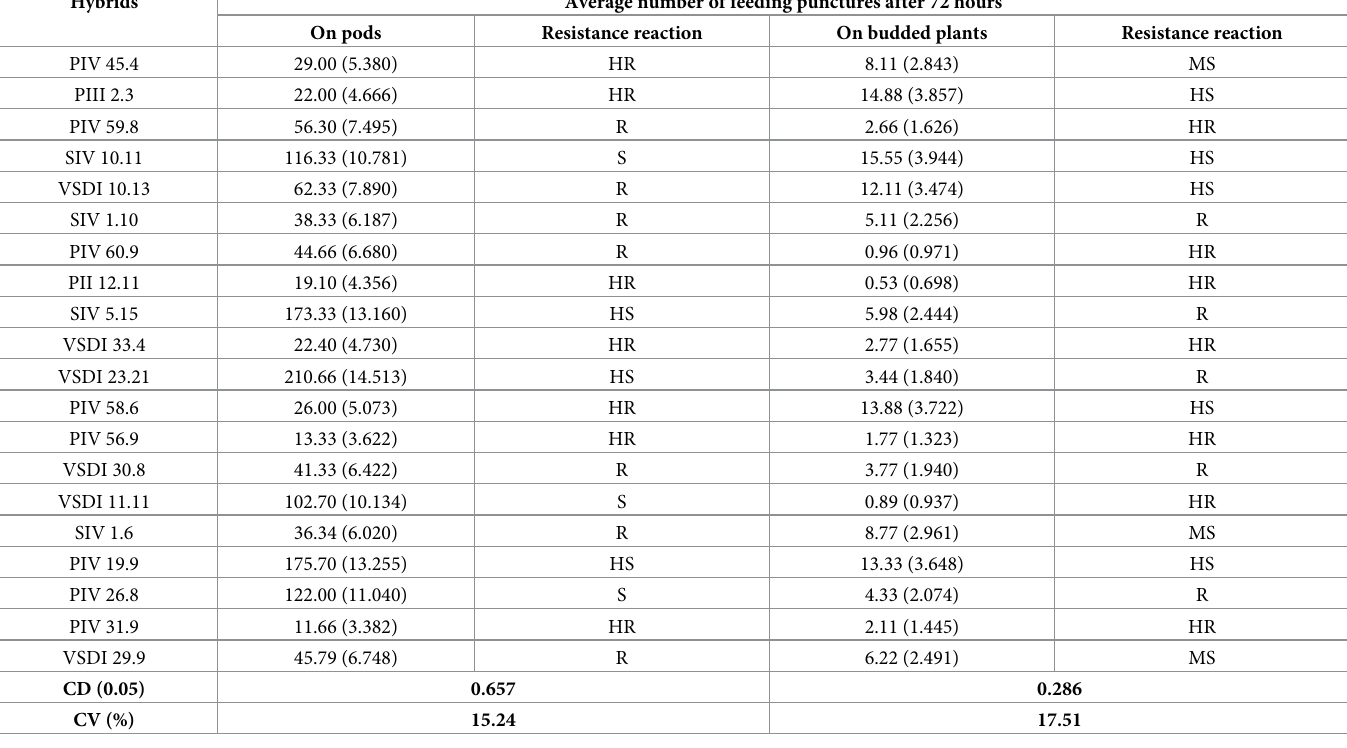
Table 3 depict the responses of cocoa hybrid seedlings to the tea mosquito bug. Based on the score chart, seven hybrids (PIV 59.8, PIV 60.9, PII 12.11, VSDI 33.4, PIV 56.9, VSDI 11.11 and PIV 31.9) were ranked as highly resistant to tea mosquito bug. After 72 hours of screening, all five hybrids had less than three lesions per plant. SIV 1.10, SIV 5.15, VSDI 23.21, VSDI 30.8, and PIV 26.8 hybrids were included in the resistant group, with feeding lesions ranging from 3.01 to 6 after 72 hours of screening. At the end of the screening, four hybrids showed a Table 3. Average number of feeding punctures after 72 hours of TMB release. Hybrids Average number of feeding punctures after 72 hours On pods Resistance reaction On budded plants Resistance